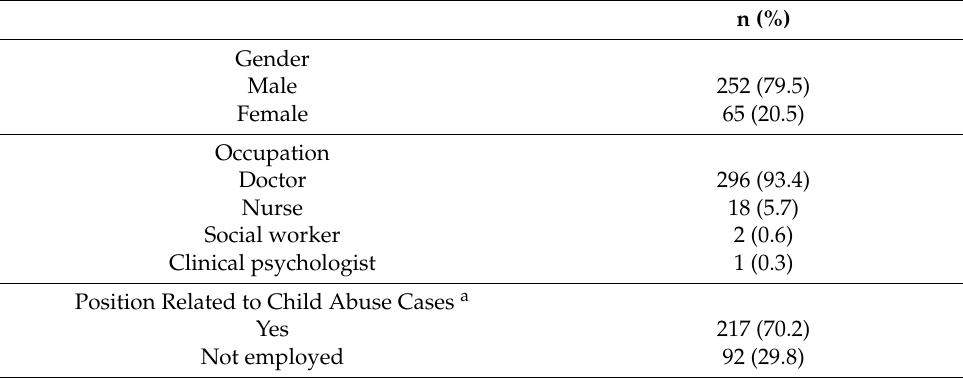
Table 2. Basic attributes of respondents (n =